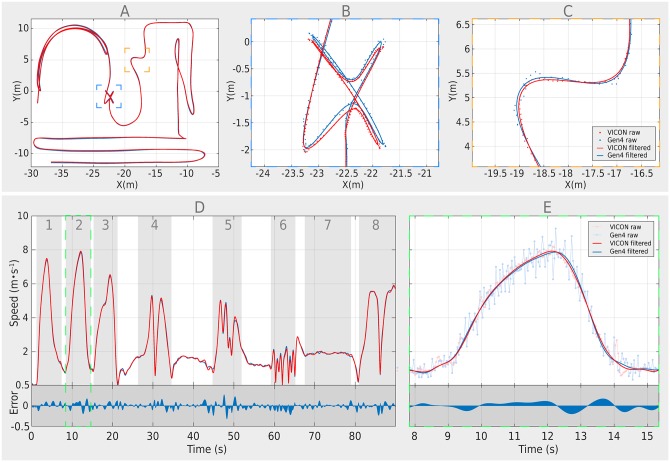
Exemplary illustration of both raw and smoothed position and speed data during a circuit.Subplot A shows the trajectories during a circuit. Subplot B and C show a magnification of two sections of the circuit (B = multidirectional lunges; C = sharp turns). Subplot D shows the derived speed including the individual sections 1–8. Subplot E shows a magnification of section2 (20m sprint).